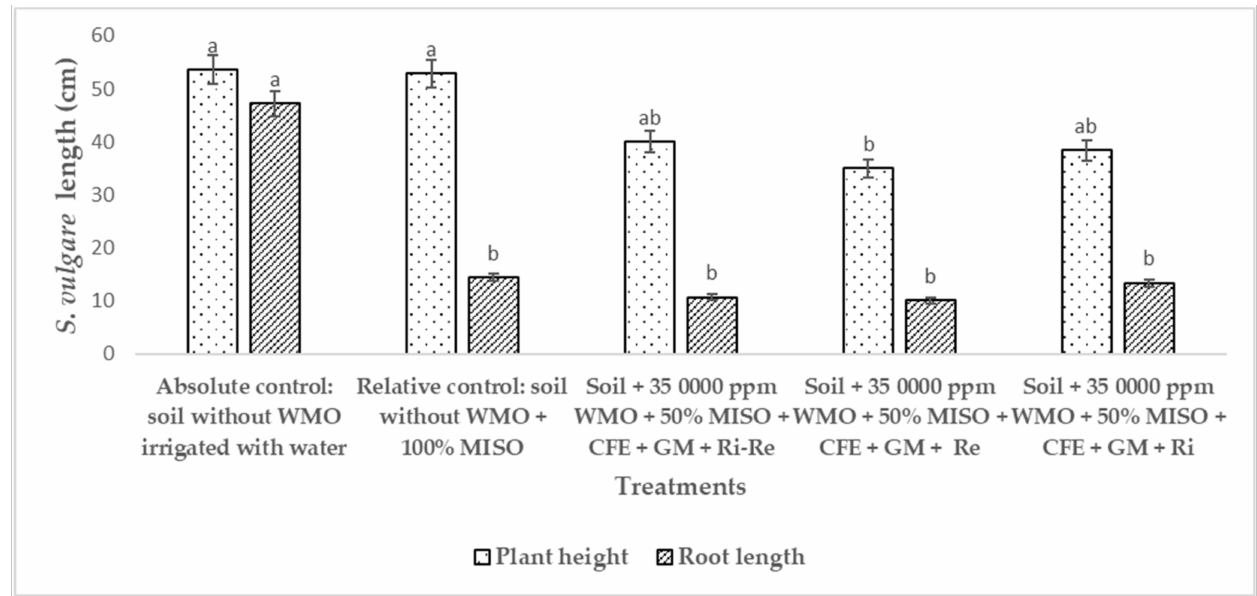
Figure 3. Phenology of Sorghum vulgare inoculated with Rhizobium etli and Rhizophagus irregularis after 120 days of phytoremediation of soil polluted by 2127 ppm WMO remaining of waste motor oil. Notes: LiP = Lignin peroxidase; MnP = Manganese peroxidase, CFE = crude fungal extract, GM = green manure, MISO = mineral solution, Ri = Rhizophagus irregularis , Re = Rhizobium etli , WMO = waste motor oil. Different letters indicate statistical difference according to ANOVA-Tukey ( p < 0.05). Number repetitions ( n ) =